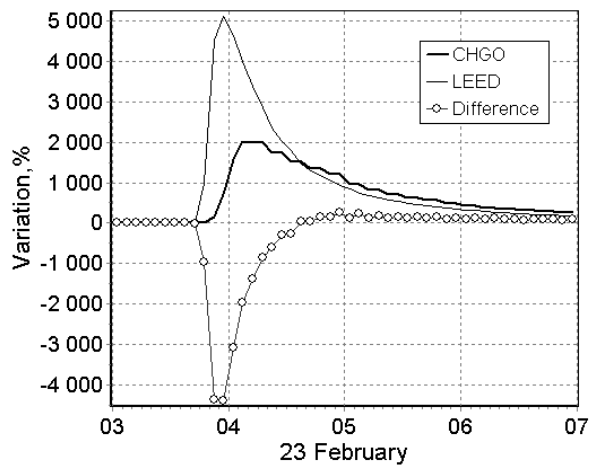
Fig. 5. Anisotropic effect of the GLE05 found as a difference of two, close to the cutoff rigidity stations Leeds and